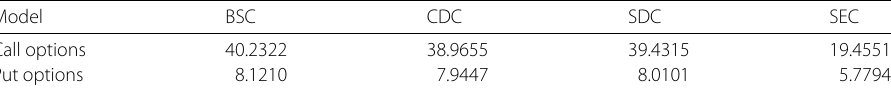
Table 1 Mean squared errors of option prices obtained by four different models for the 1/100 Dow Jones Industrial Average option prices